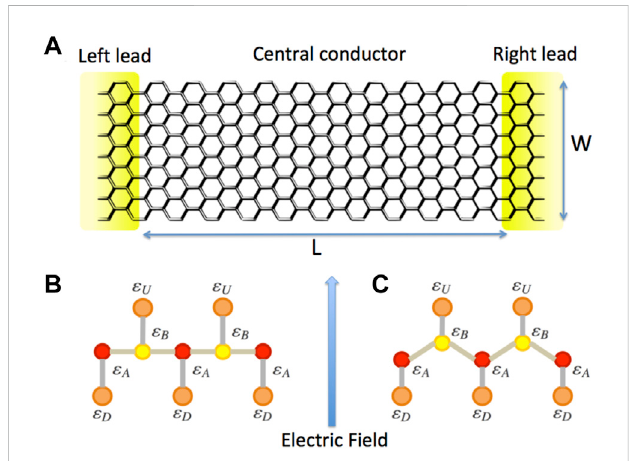
FIGURE 1 (A) Schematicview of theconsidered ASNR, (B) and (C) sideview of the planar ( α = 0) and the non-planar ( α ≠ 0) Silicene nanostructures. In this panel, ε ( U , D ) represents the on-site energy of the ad-atoms pinned at the A(B) ribbon